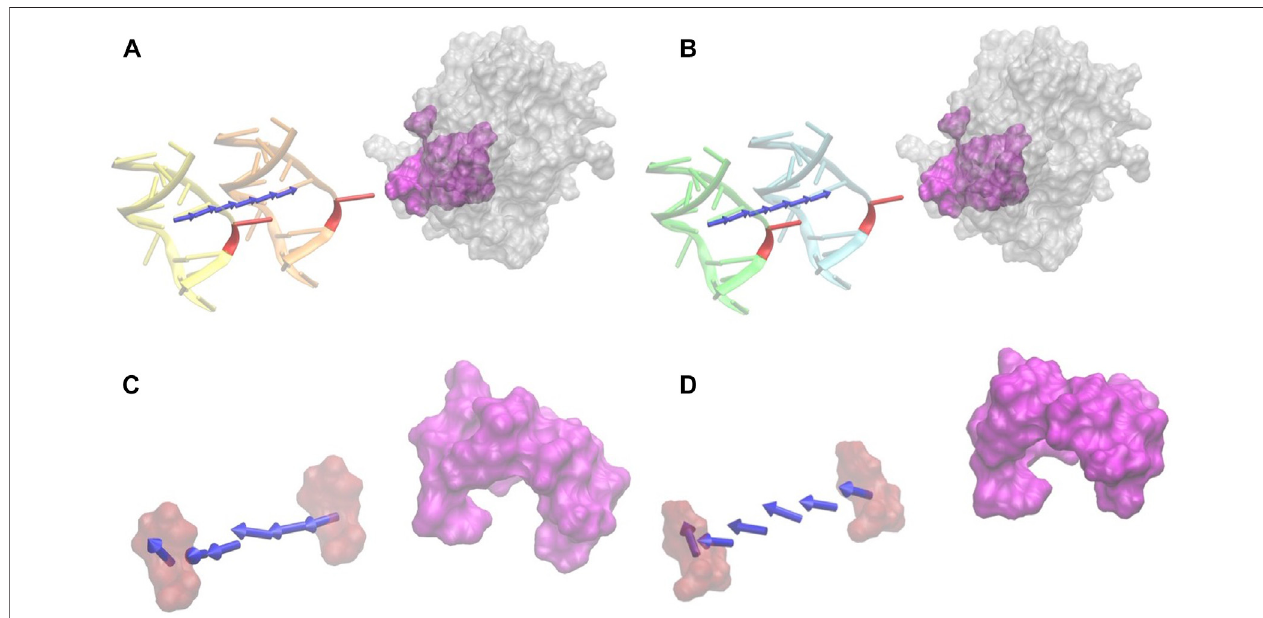
FIGURE5| ElectrostaticforcesofDNA_RUandDNA_CatvariabledistanceswithUDG. (A) Theelectrostatic-bindingforcedirectionsbetweenDNA_RUandUDG with the distances from 20 Å (orange) to 40 Å (yellow) with the step size of 4 Å. Red marks the B5 base uracil in the DNAs, and magenta is the binding pocket area in UDG. (B) TheelectrostaticbindingforcedirectionsbetweenDNA_CandUDGwiththedistancesfrom20 Å(cyan)to40 Å(green)withthestepsizeof4 Å.Redmarksthe B5 base cytosine in the DNAs, and magenta is the binding pocket area in UDG. (C) The electrostatic force directions between the uracil base (red) and the UDG pocket (magenta) with the distances from 20 Å to 40 Å. (D) The electrostatic binding force directions between cytosine base (red) and the UDG pocket (magenta) with the distances from 20 Å to 40 Å. In this fi gure, only the force directions are considered rather than the force